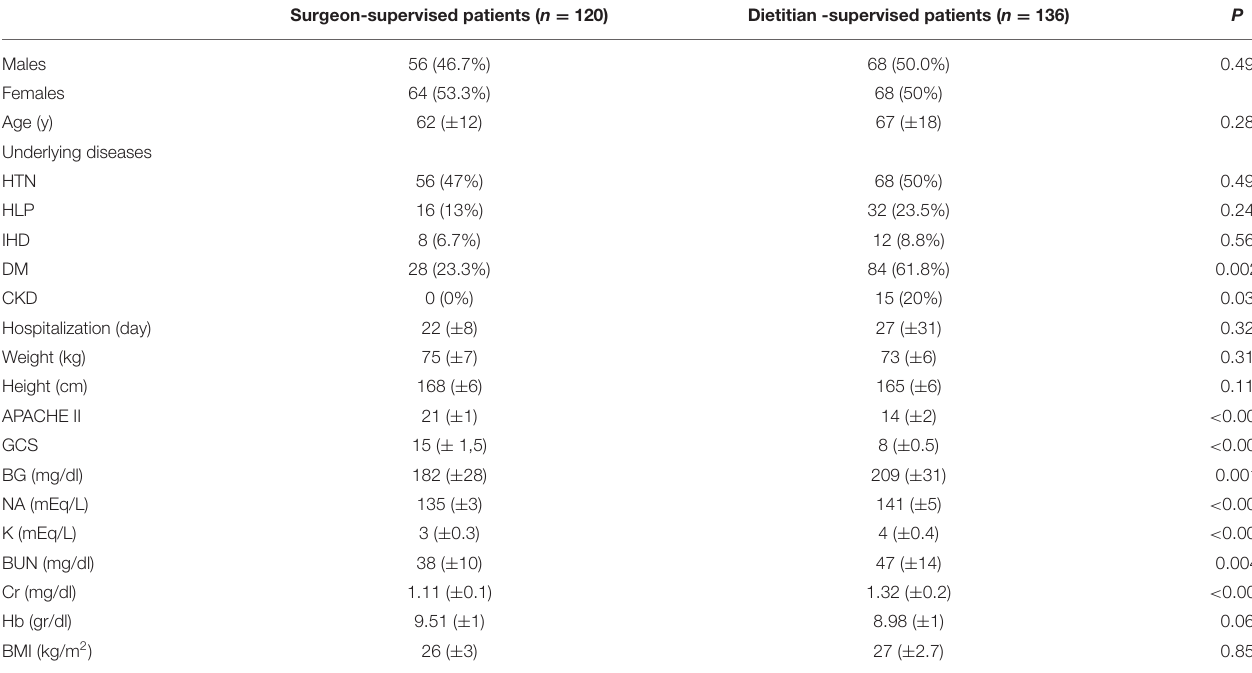
TABLE 1 | Characteristics of the patients. Surgeon-supervised patients ( n = 120) Dietitian -supervised patients ( n =